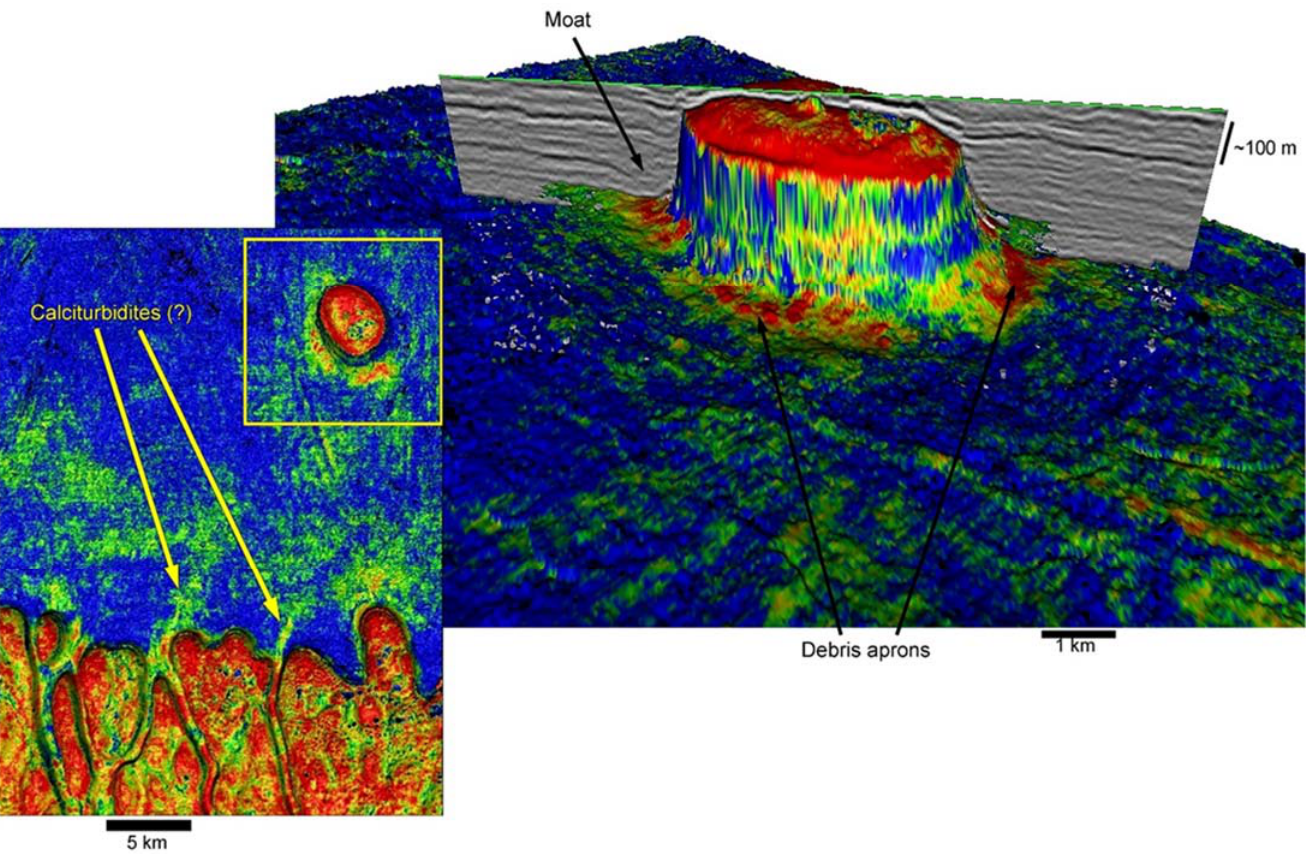
Figure 1. Seismic attributes (Root-Mean-Square Amplitude) showing geomorphology of the paleo- seabed reef features. Source: courtesy of Virtual Seismic Atlas (VSA), 2015 (www.seismicatlas.org, accessed on 1 January 2015). (VSA author: Henry Posamentier).